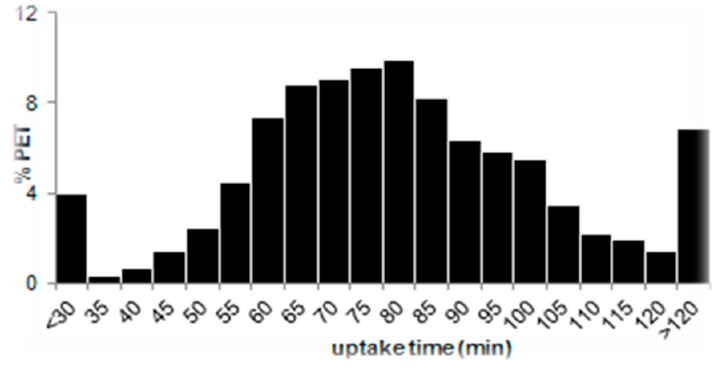
Figure 4. Histogram of uptake time in 1700 PET/CT scans acquired from over 56 PET sites across the world. The average uptake time is 79 ± 28 min (range 23–256).